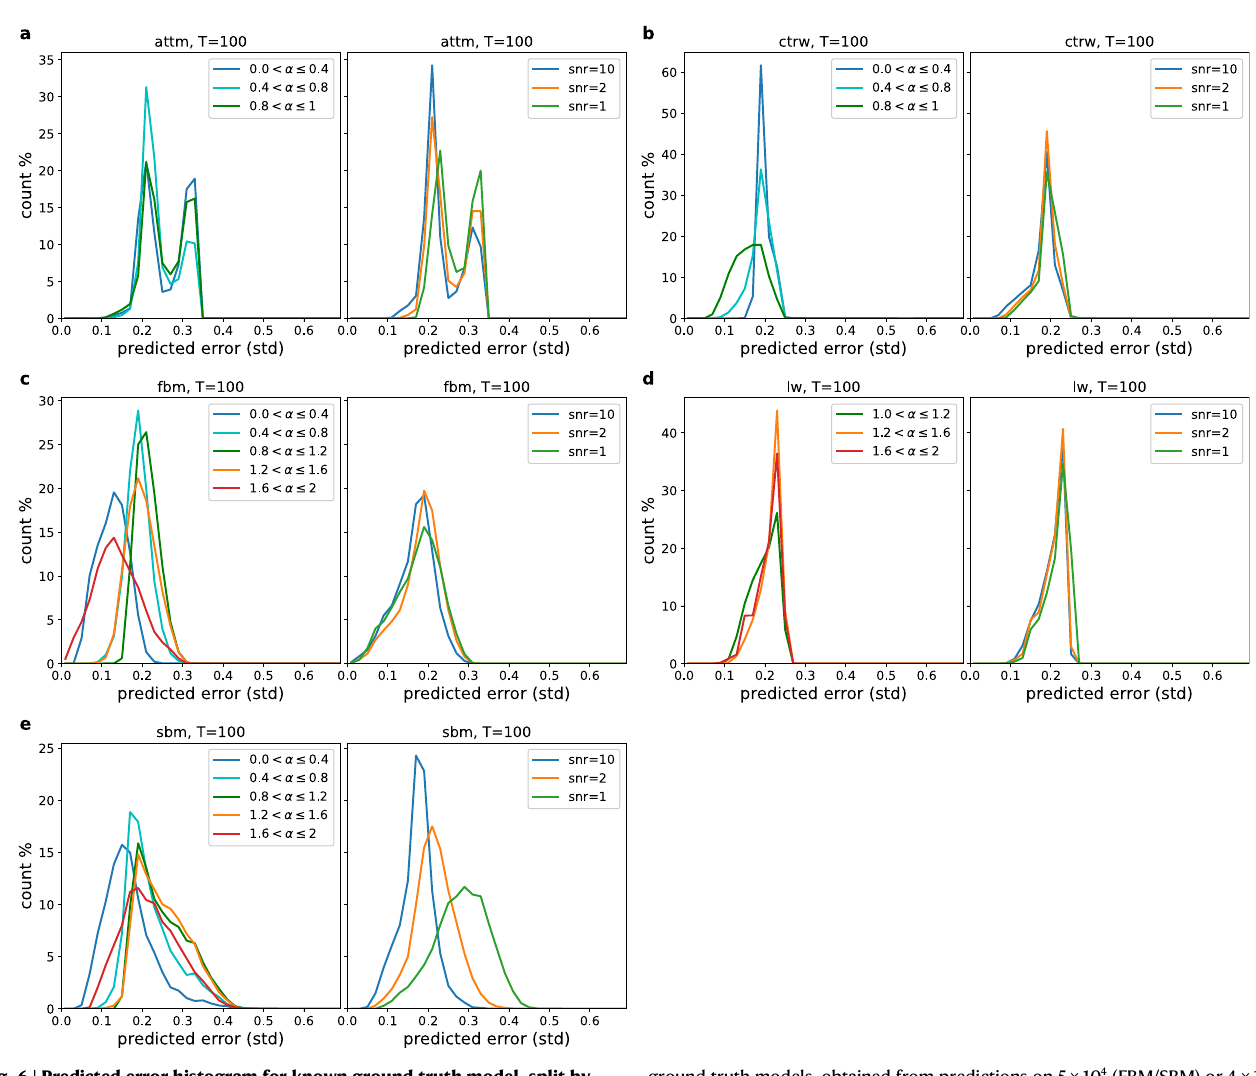
ground truth models, obtained from predictions on 5×10 4 (FBM/SBM) or 4×10 4 (ATTM/LW/CTRW)